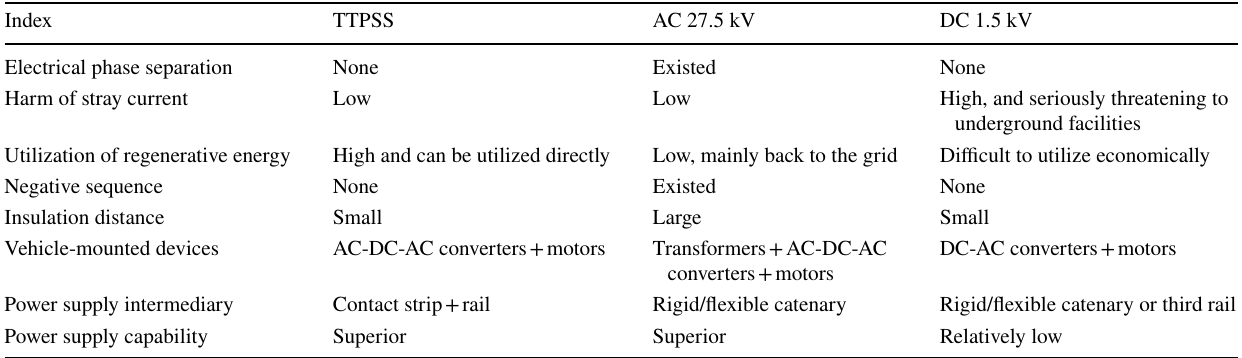
Table 6 Technical comparison of power supply